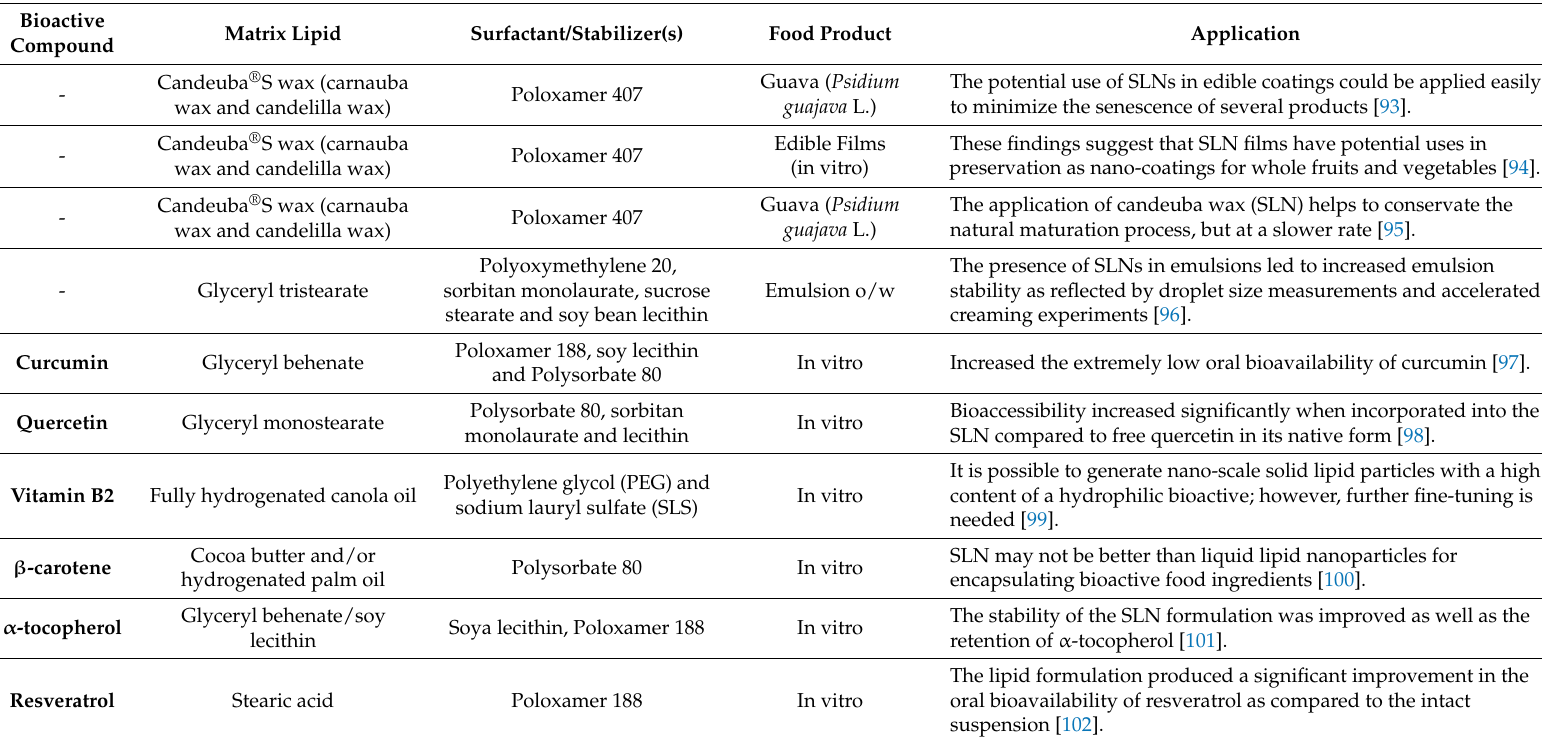
Table 2. Examples of SLN applications in the food